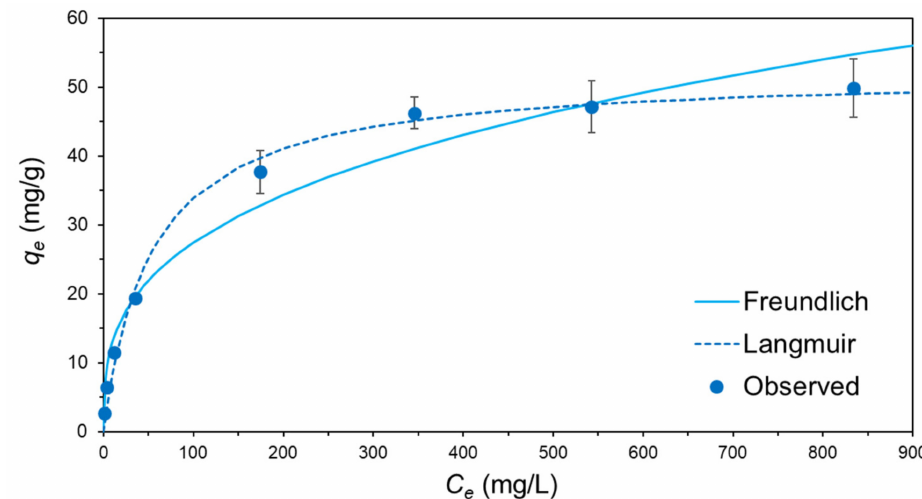
Figure 9. Equilibrium models of As(III) adsorption onto Al-FWB with initial As(III) concentrations of 10–1000 mg/L at 25 ◦ C and 100 rpm agitation for 24 h.